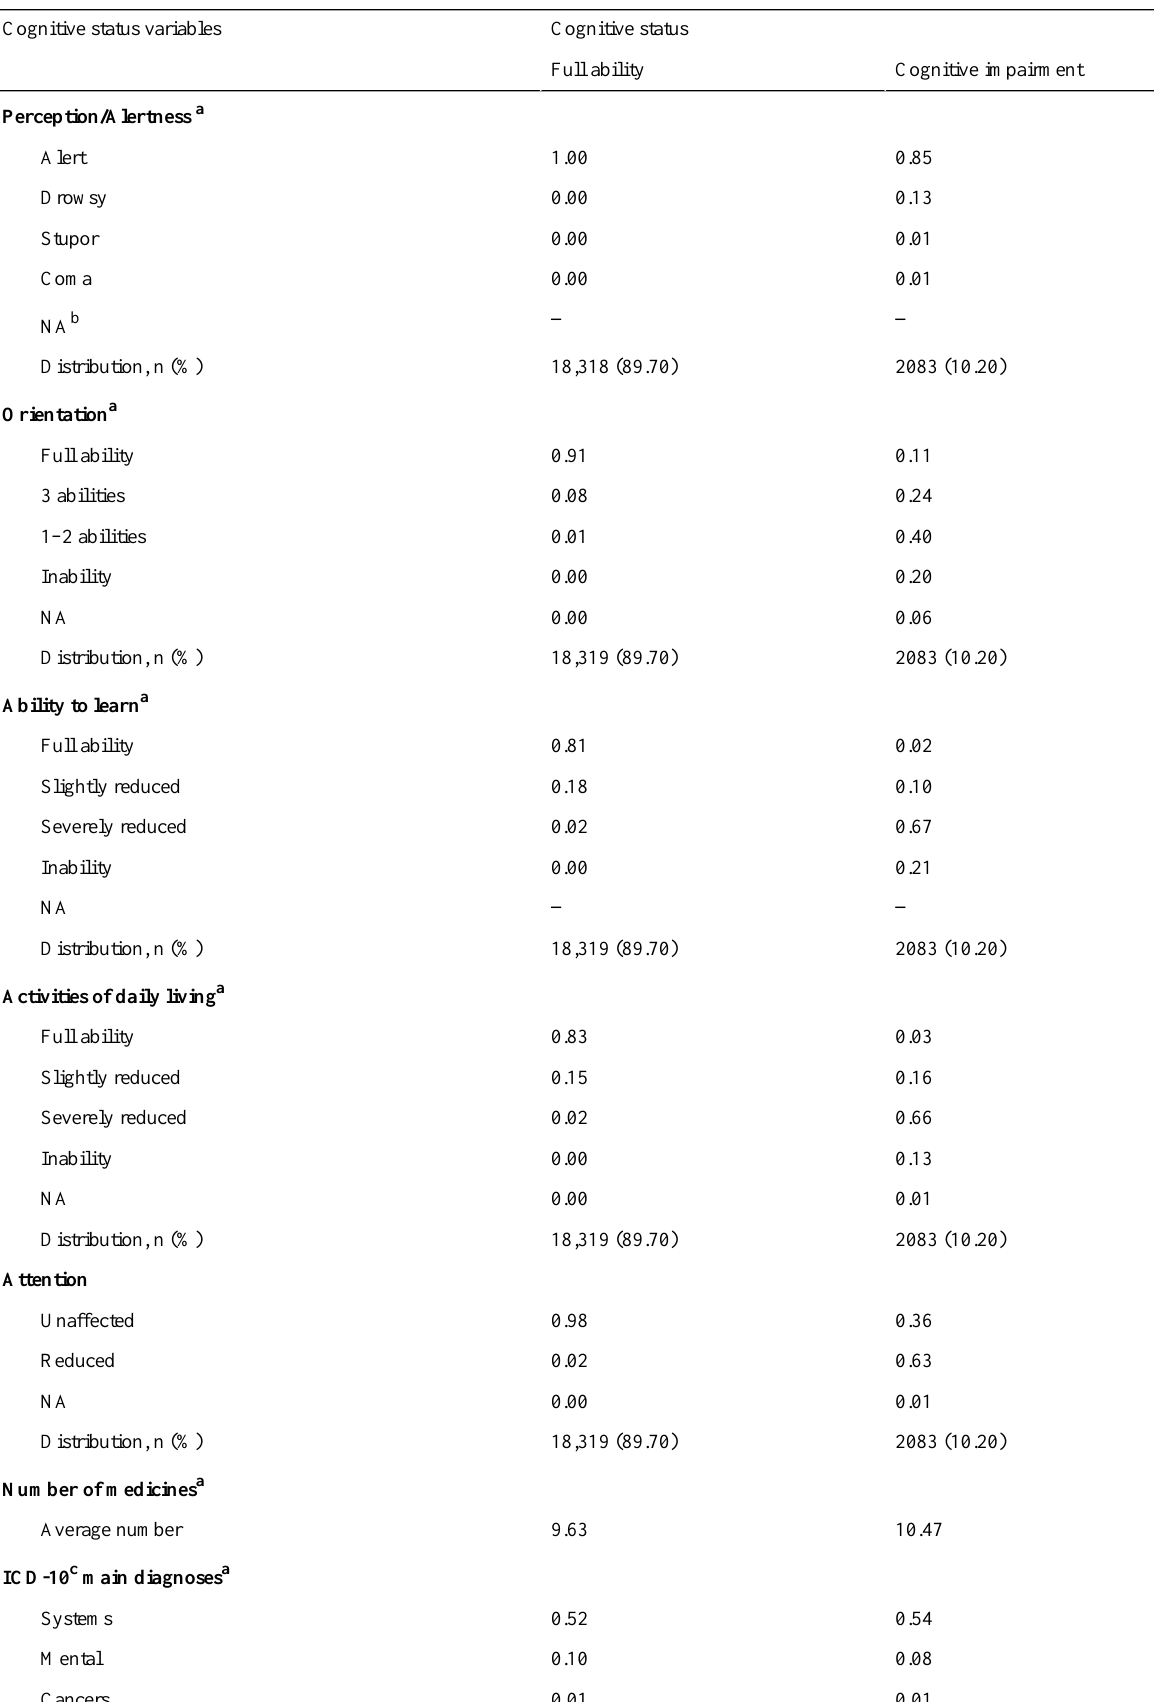
Table 1. Distribution of individuals in each group for all 5 cognitive status variables in the 2-cluster solution (N=20,422).